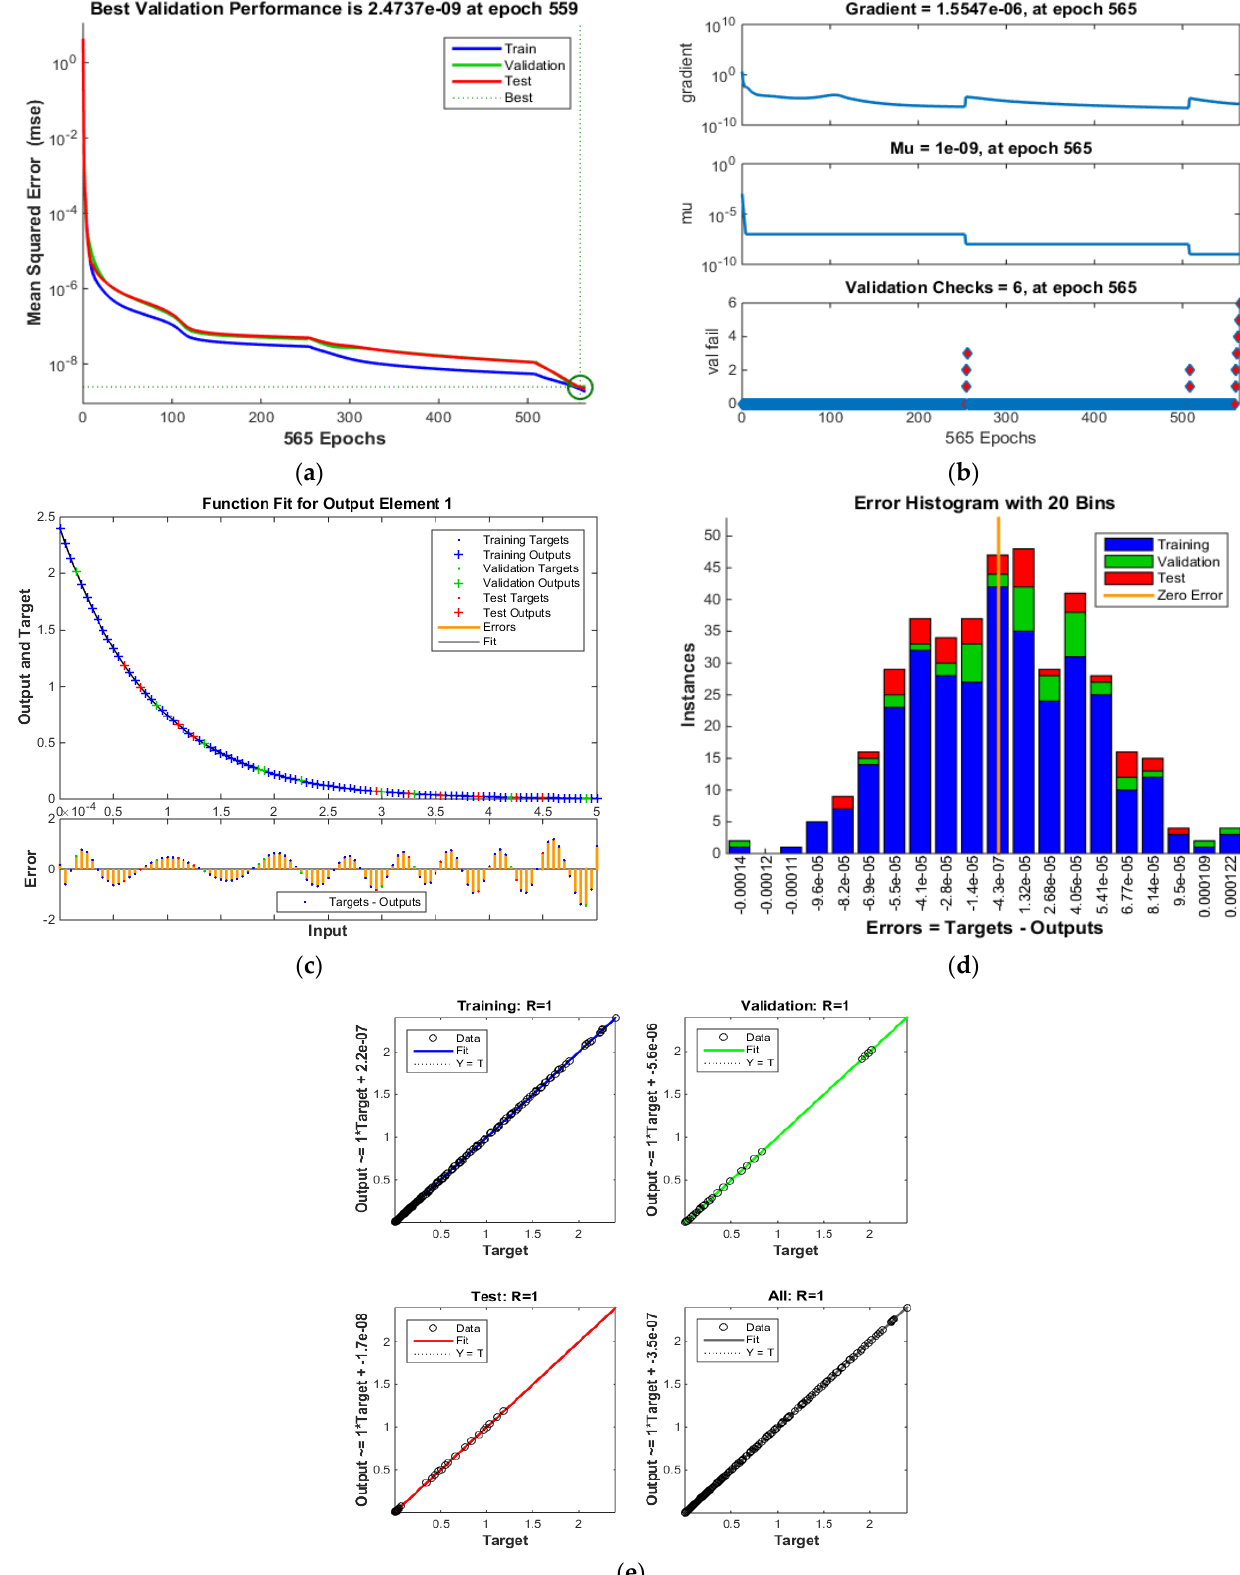
Figure 5. Graphic representation for designed LMT-ABPNN for solving cases of 𝑀 for 𝑓′(𝜂) of MHD-SGFM. ( a ) MSE Result, ( b ) Results of the transition state, ( c ) Fitness of the curve, ( d ) Histogram for error analysis, ( e ) Regression.